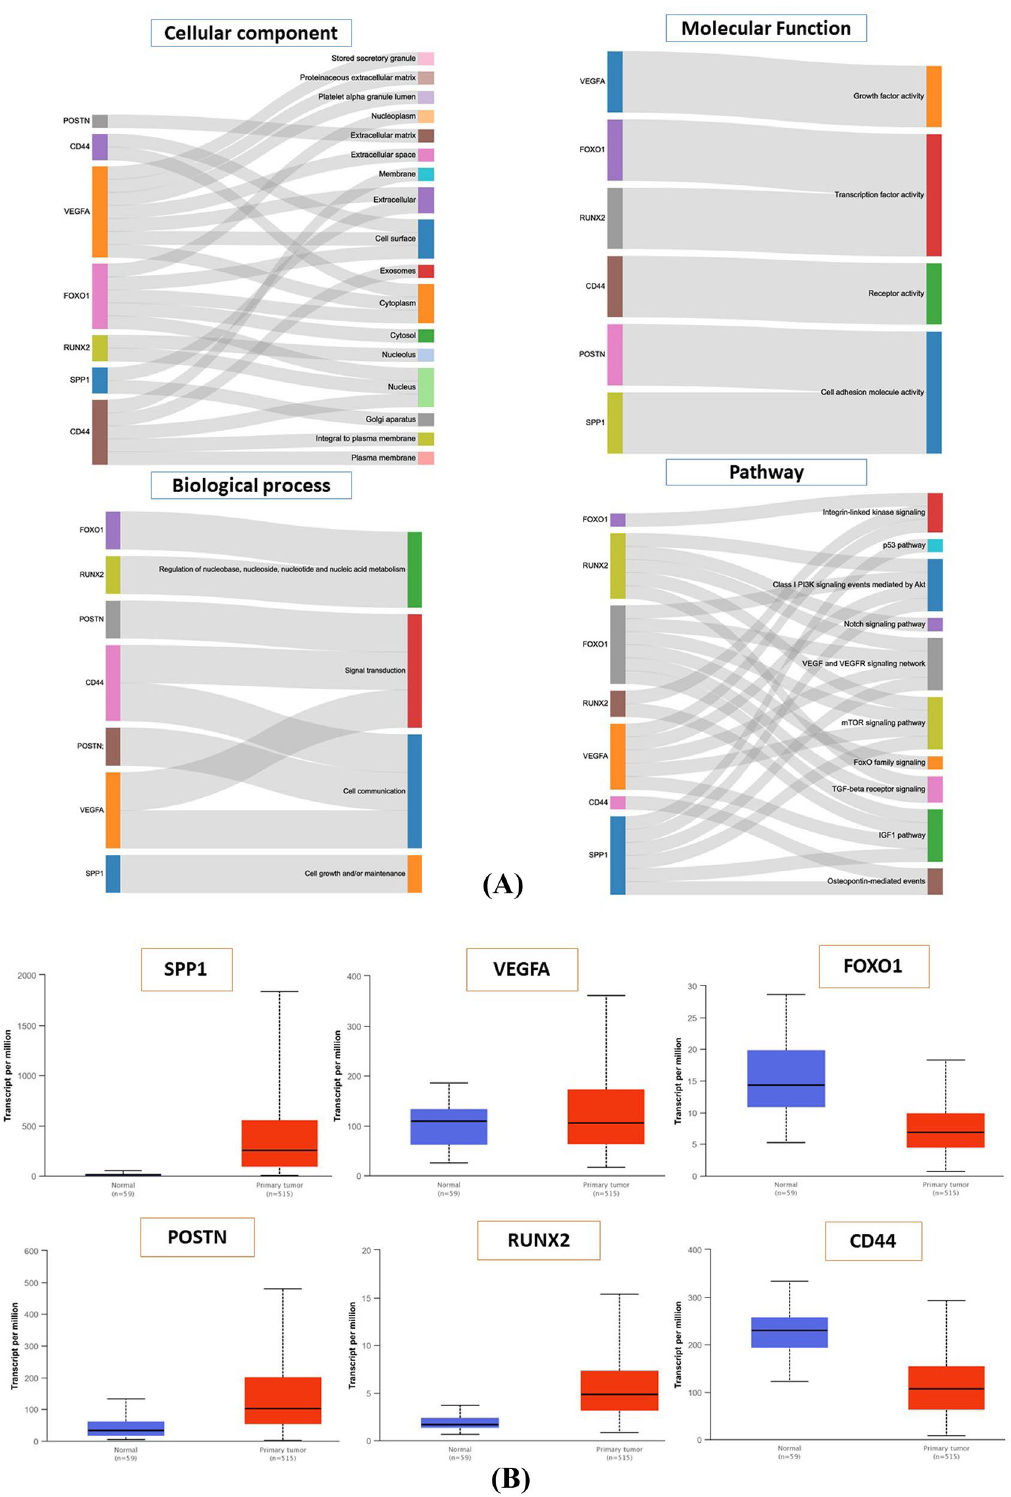
Figure 2. ( A ) The top six differentially expressed genes GO terms. Each of the graph show a biological process, molecular functions, cellular component and pathway involvement of the genes. ( B ) mRNA expression of SPP1 , VEGFA , FOXO1 , RUNX2 , CD44 and POSTN genes in lung cancer tissues and adjacent normal lung tissues. ( C ) Relationship between mRNA expression of hub genes and individual cancer stages of lung cancer patients. ( D ) Immunohistochemistry images of six genes in Lung cancer tissues and normal lung tissues (Human Protein